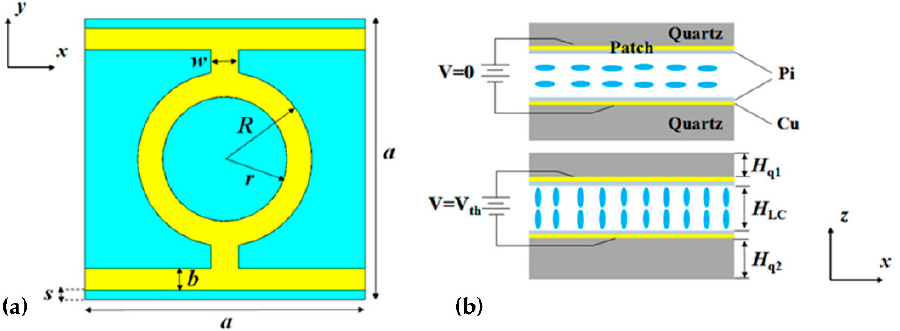
Figure 15. Schematic diagram of a metamaterial absorber based on liquid crystals [80]: ( a ) top view and ( b ) side view. Reprinted with permission from Ref. [80]. 2018 MDPI.